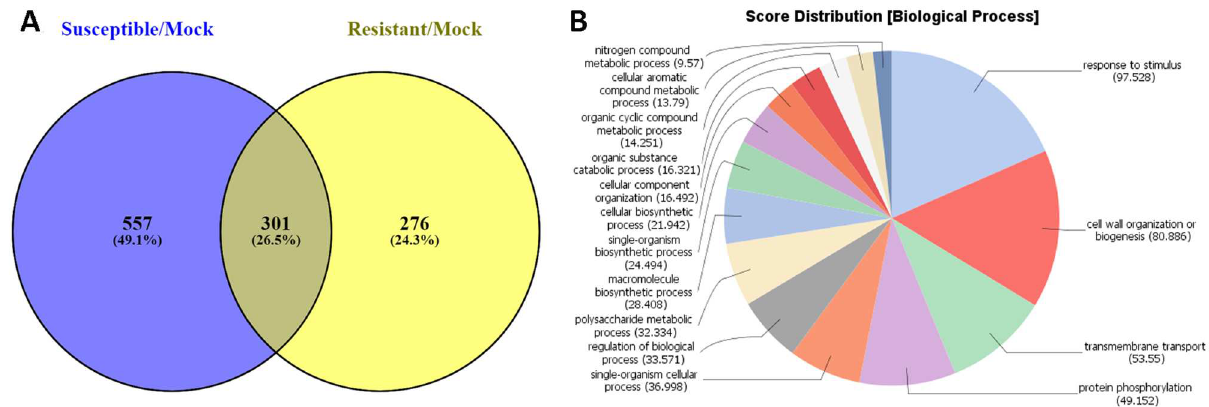
Fig 3. Down-regulated differentially expressedgenes (DEGs) in alfalfa plants from cultivar Maverick.(A) Venn diagram depictingthe uniqueand common down-regulatedDEGs betweensusceptibleand resistant plants at 72 hours after inoculation. (B) Functional profilingof the uniquegenes down-regulatedin susceptibleMaverick